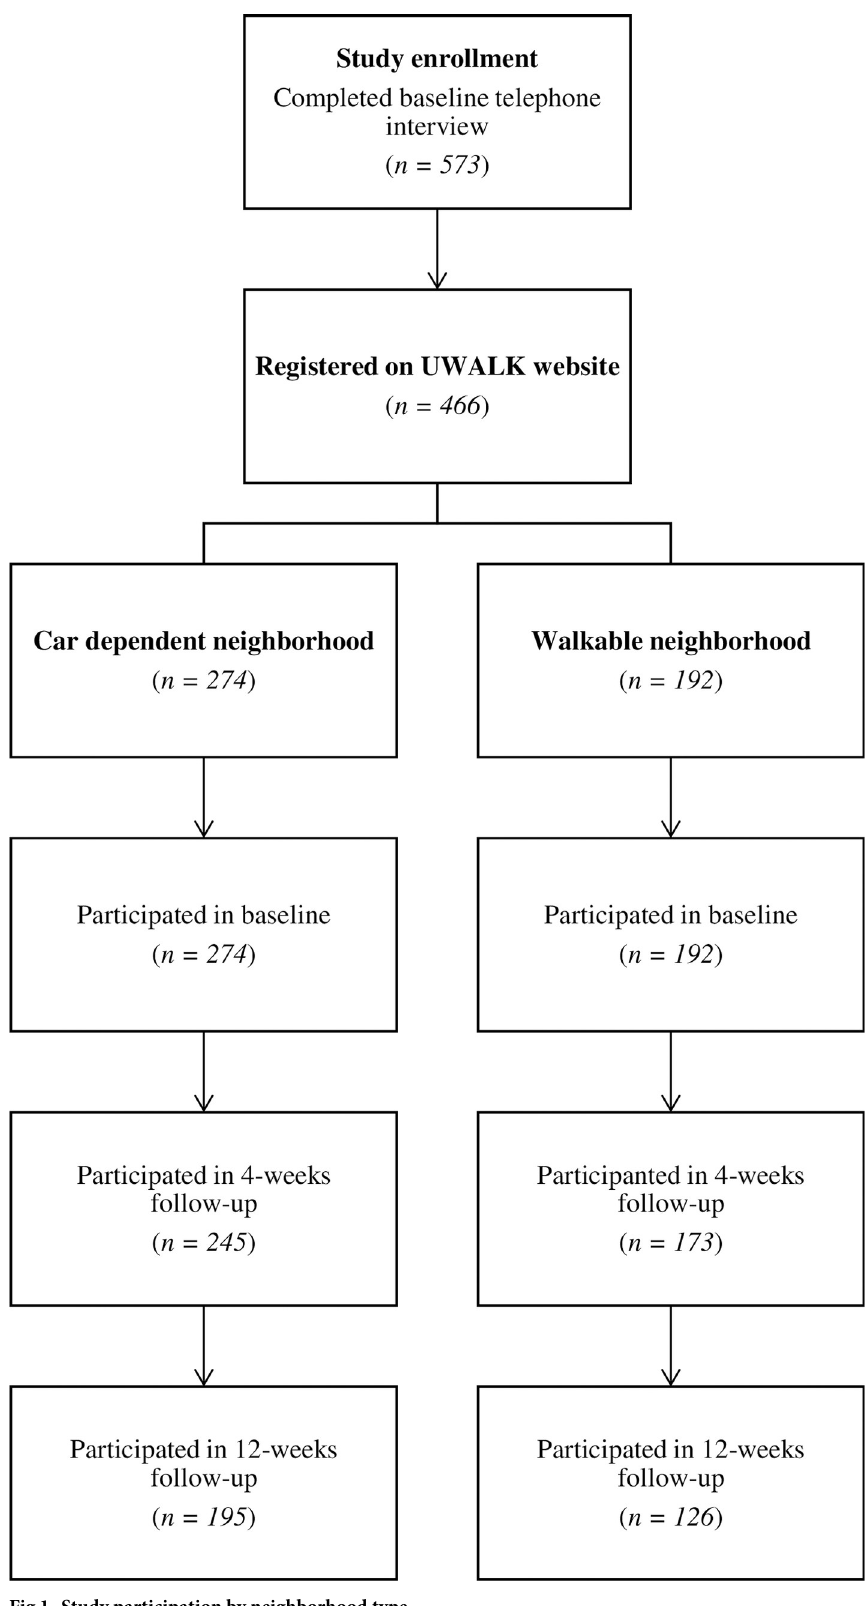
Fig 1. Study participation by neighborhood